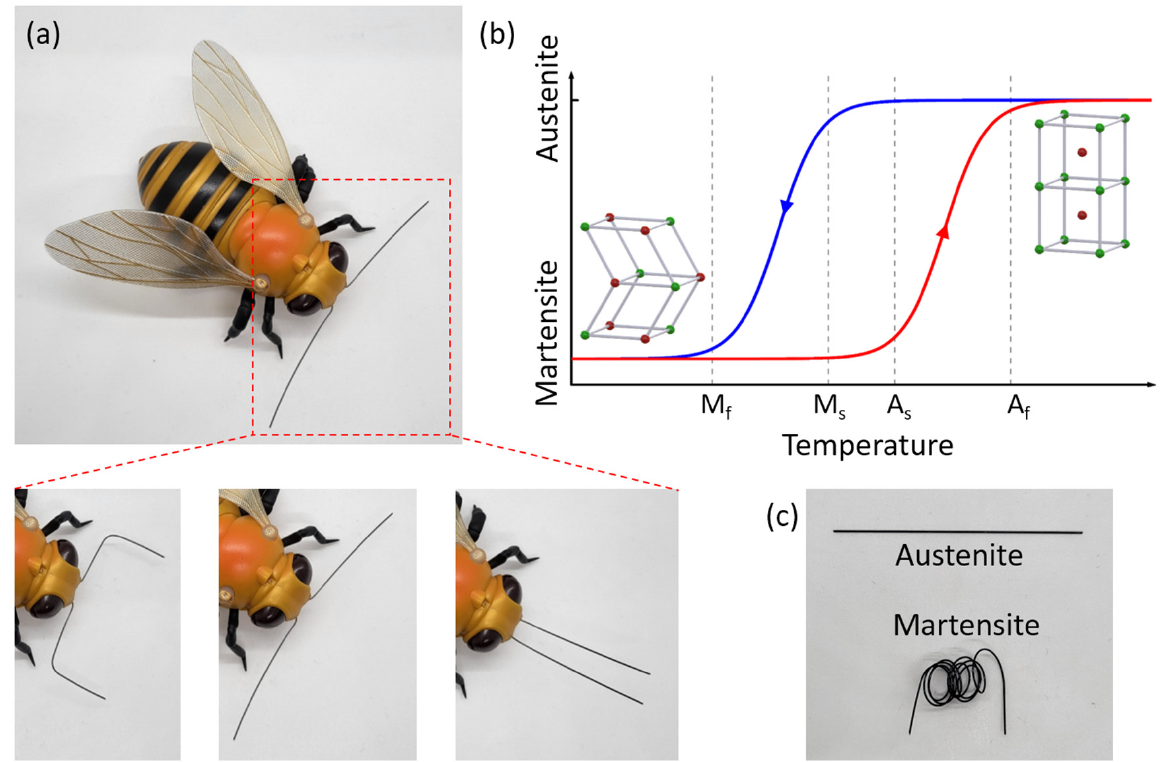
Figure 1. ( a ) ShMoA can be used for thermal perception in robots—changes shape based on temperature. ( b ) The hysteresis and critical temperature threshold of shape memory alloy is utilized for temperature sensing. The red curve is for heating process and the blue curve is for cooling process. ( c ) photo of SMA wires under martensite and austenite state at different temperatures.